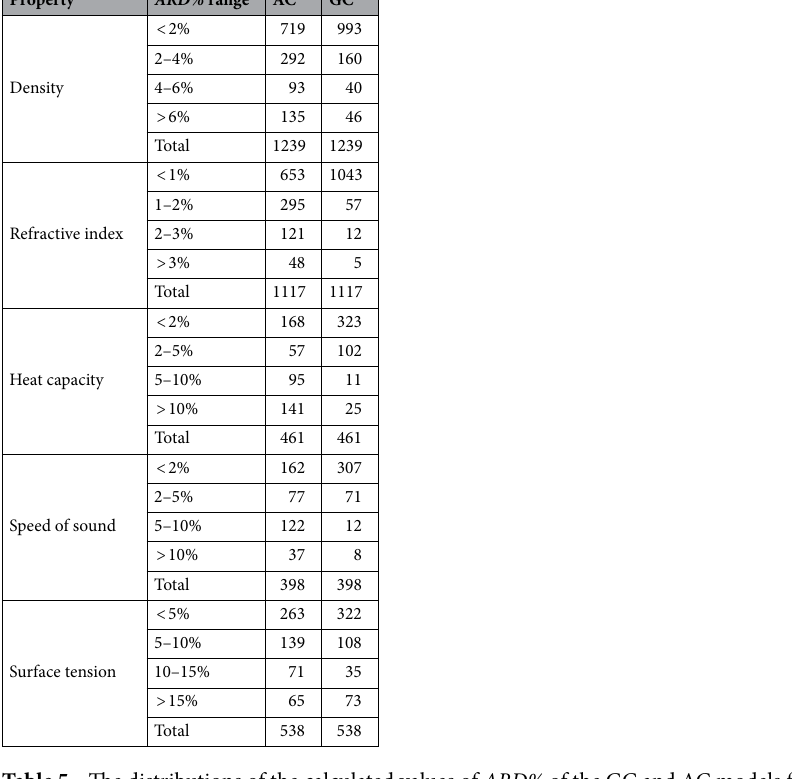
Table 5. The distributions of the calculated values of ARD% of the GC and AC models for density, refractive index, heat capacity, speed of sound and surface